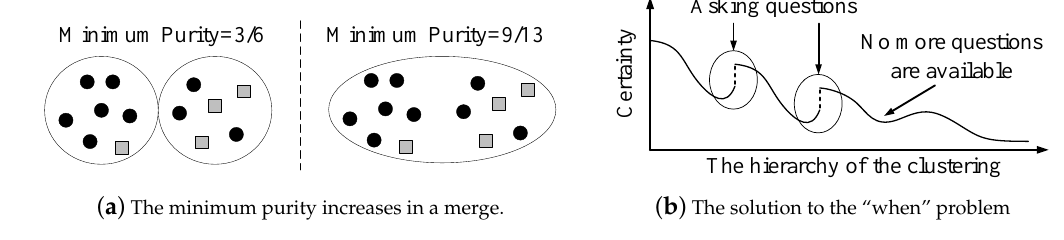
Figure 5. The minimum purity and the “when”